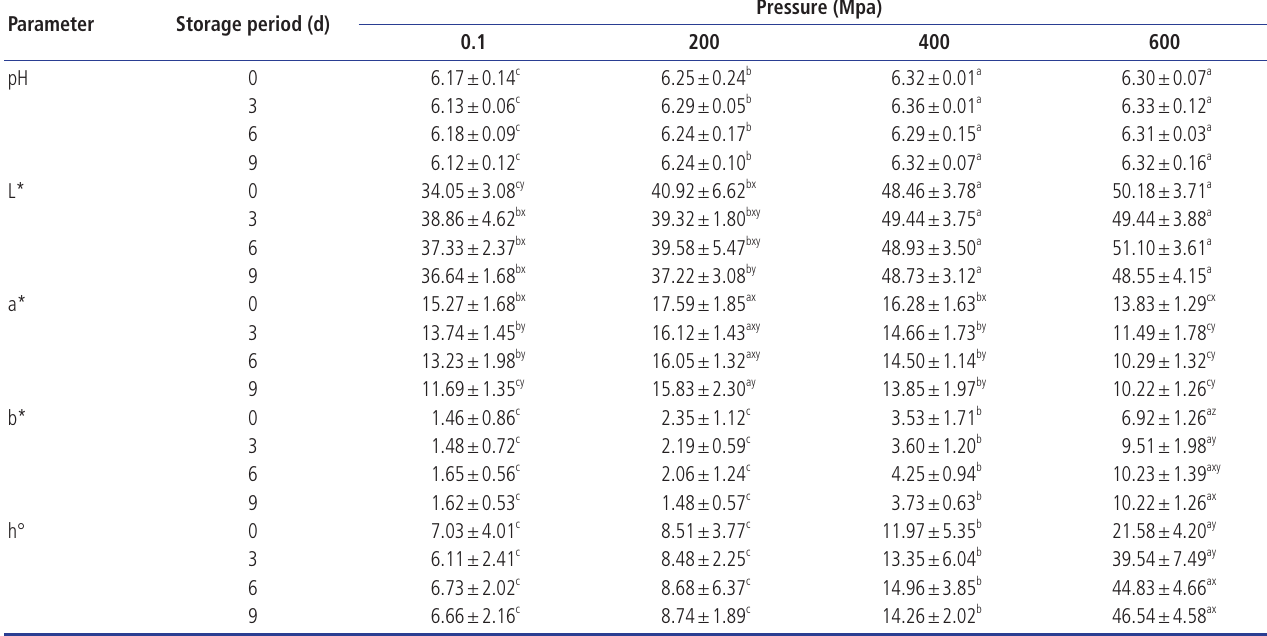
Table 3. Changes in meat pH and instrumental surface color of DFD strip loin subjected with different levels of pressure during refrigerated storage under vacuum Parameter Storage period (d)